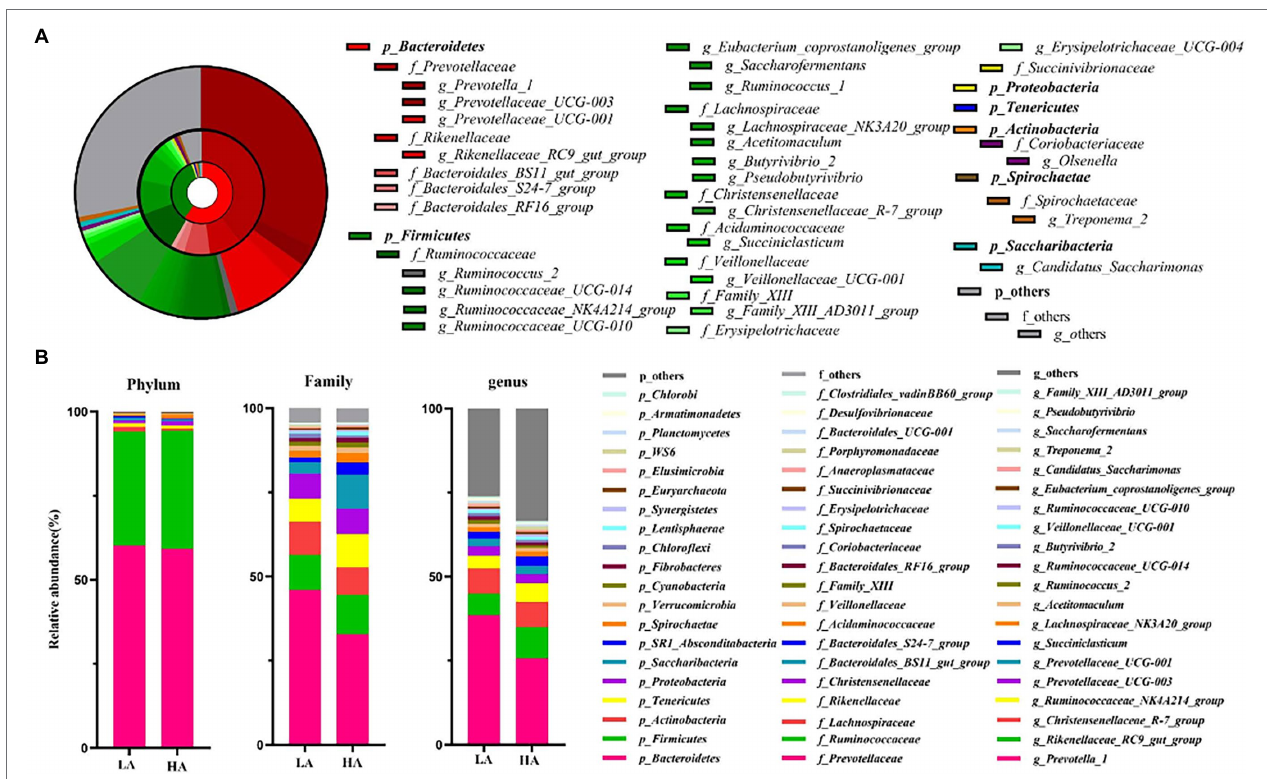
FIGURE 1 | Composition of ruminal bacteria in Sanhe heifers. (A) Relative distribution of the most dominant bacterial phyla, families, and genera (relative abundance >0.5% for 20 samples) in the LA and HA groups. The inner, middle, and outer rings represent the phylum, family, and genus levels, respectively. Different shades of color represent different bacteria. (B) Top 20 average relative abundance of phyla, family, and genus in the LA and HA groups. LA, low-altitude group and HA, high-altitude